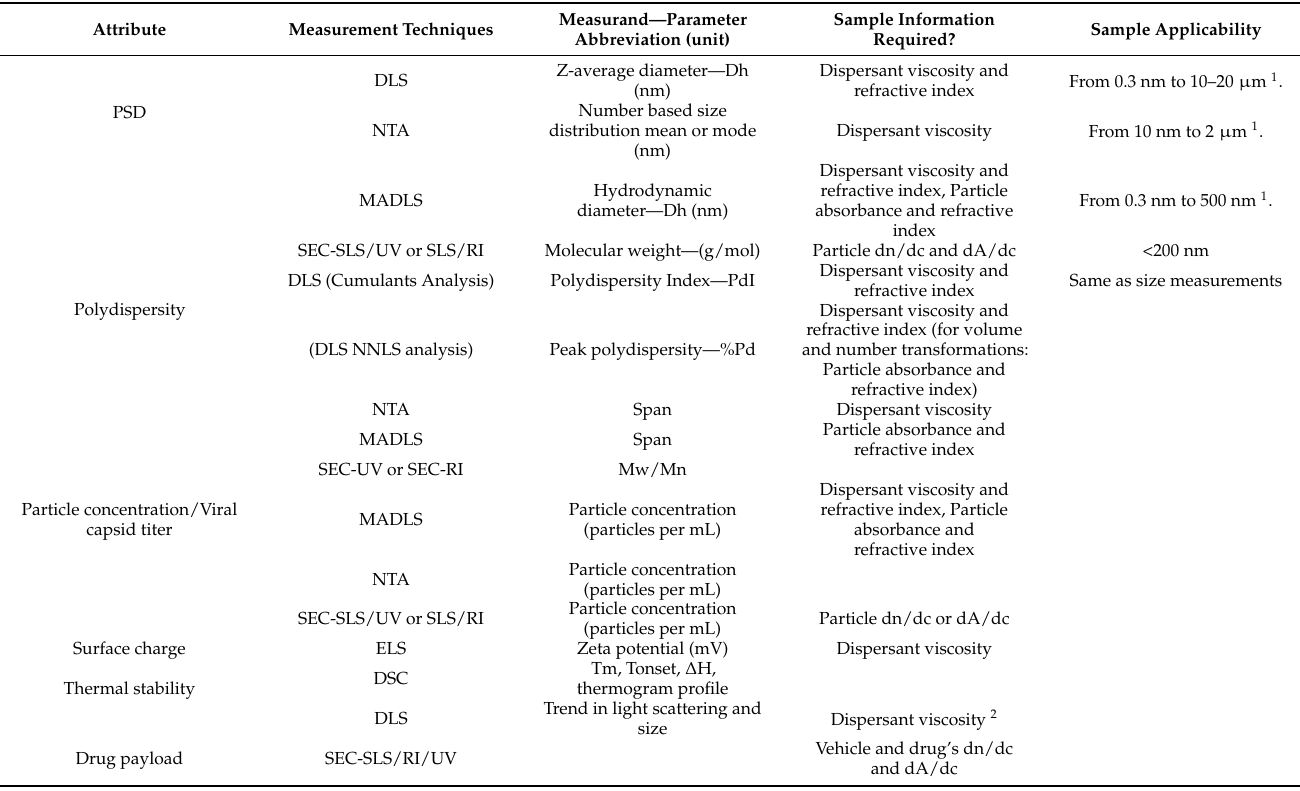
Table 10. Sample attributes measured in this study, with corresponding techniques and measurands reporting on the